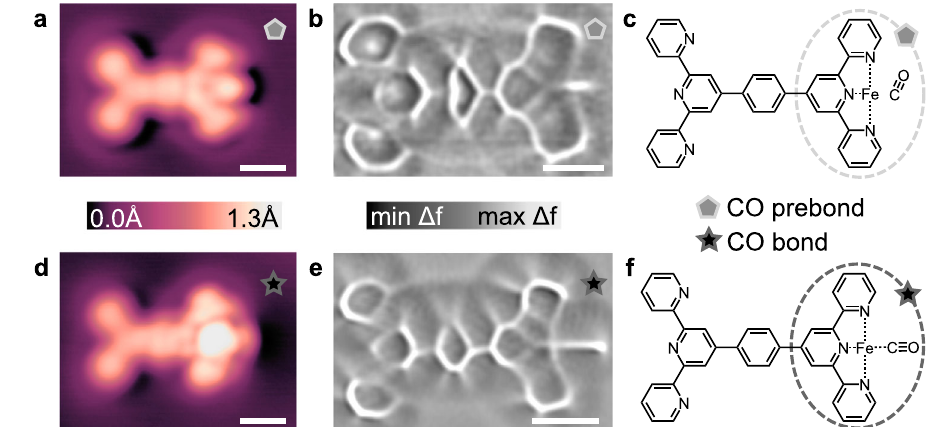
Fig. 3 | STM and ncAFM of CO associated Fe-tpy structures. Comparison of CO prebond ( a – c ) and CO bond ( d – f ) con fi gurations. STM topographs ( a , d ) were imagedwithCO-terminatedtipsat V =20mVand I =10pA.ConstantheightncAFM images (Laplace- fi ltered) for the CO prebond ( b ) and CO bond ( e ) motifs show a distinctdifferenceinthelengthoflinesattherightsideofthemoleculeswherethe